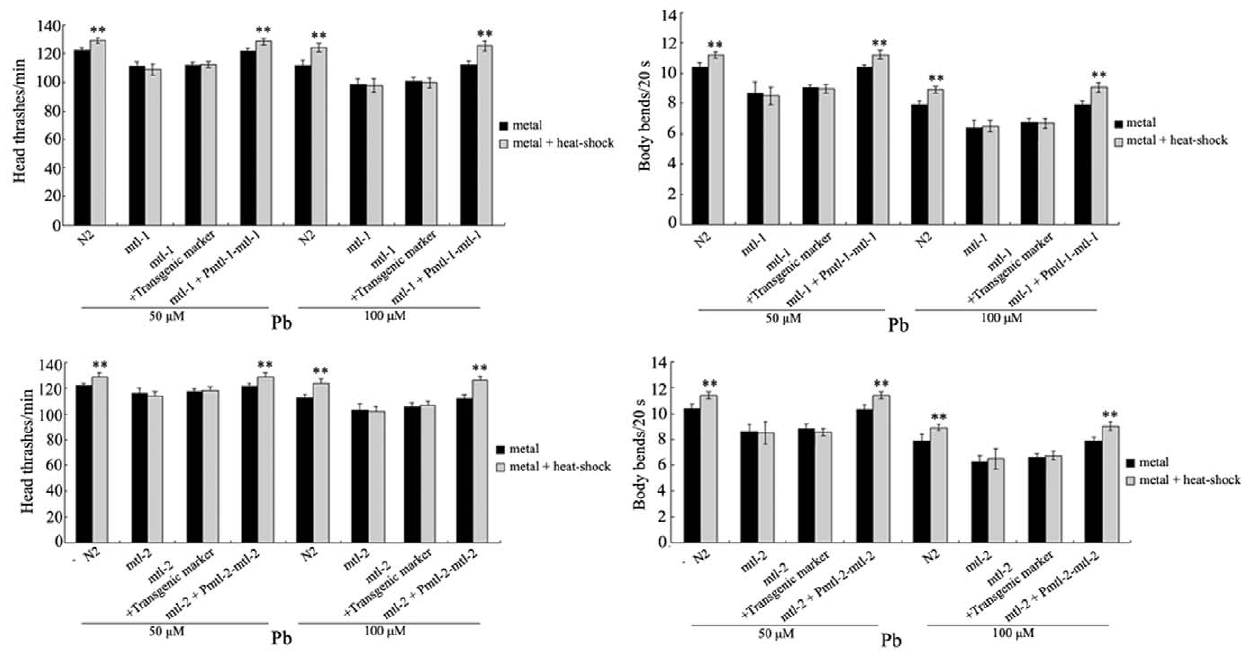
Figure 7. The defects of adaptive response to neurobehavioral toxicity induced by Pb exposure in mtl-1(tm1770) and mtl-2(gk125) mutants can be rescued by the expression of mtl-1 and mtl-2 with their native promoters. L2-stage larvae animals were heat stressed for 1 h at 36 u C. The exposed metal concentrations were 50 and 100 m M. The plasmids were injected as a mix at 20 ng/ m l using P dop-1::rfp as a transgenic marker. Bars represent means 6 S.D. ** p , 0.01 vs metal.